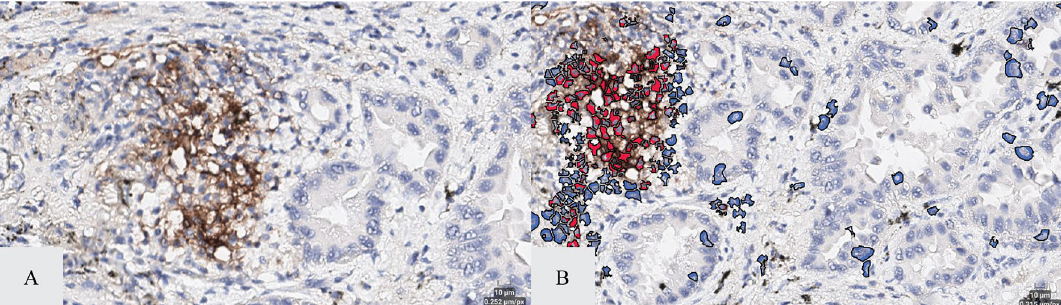
Figure 6. Macrophage identification and PD-L1 positivity IA solution. Panel ( A ) shows a field of view of intra- tumoral macrophages. Panel ( B ) shows the same field of view with labeled macrophages (as identified by the recognition algorithm) with and without PD-L1 staining (red = PD-L1 positive; blue = PD-L1